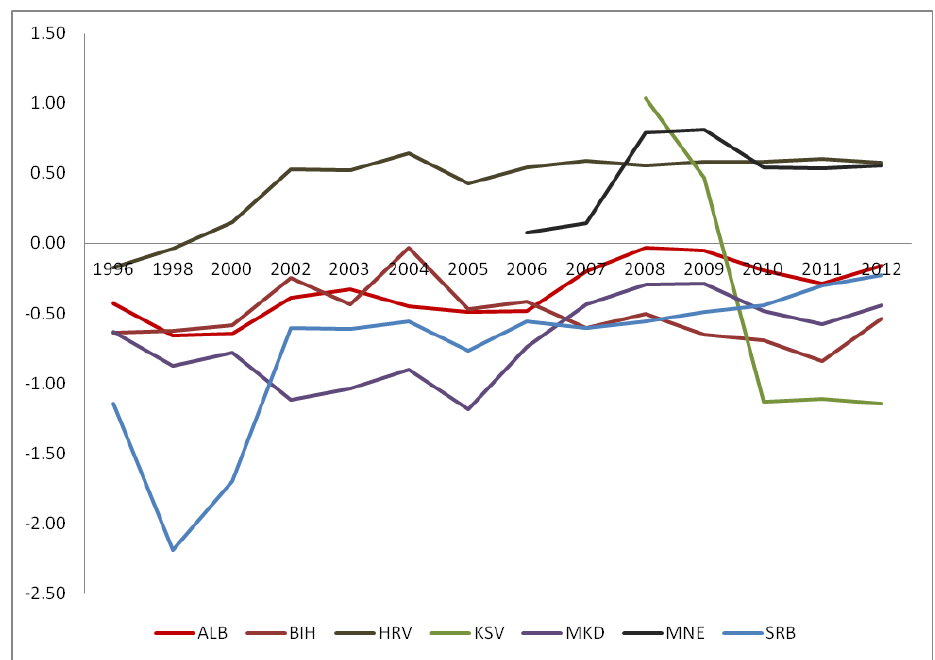
Source: World Bank , Worldwide Governance Indicators (WGI), 2013 As shown in the graph, this indicator shows an improvement for all the countries in the period 1996 - 2000 and a relative stabilization after 2001. In general, for this group of countries the index is between -0.5/+0.5 (ranking 45 – 55 from about 230 countries). The highest evaluation is for Croatia while the lowest is for Kosovo (-0.22 in 2012). Graph 2. Political stability and no violence (1996 –